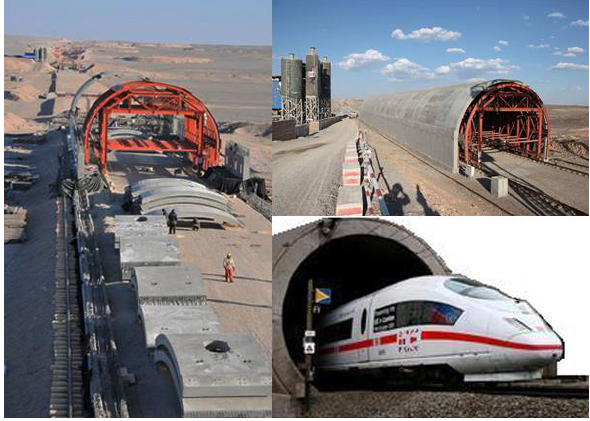
Figure 1. Wind barriers shaped cut-and-cover tunnels for some high-speed railway in China.